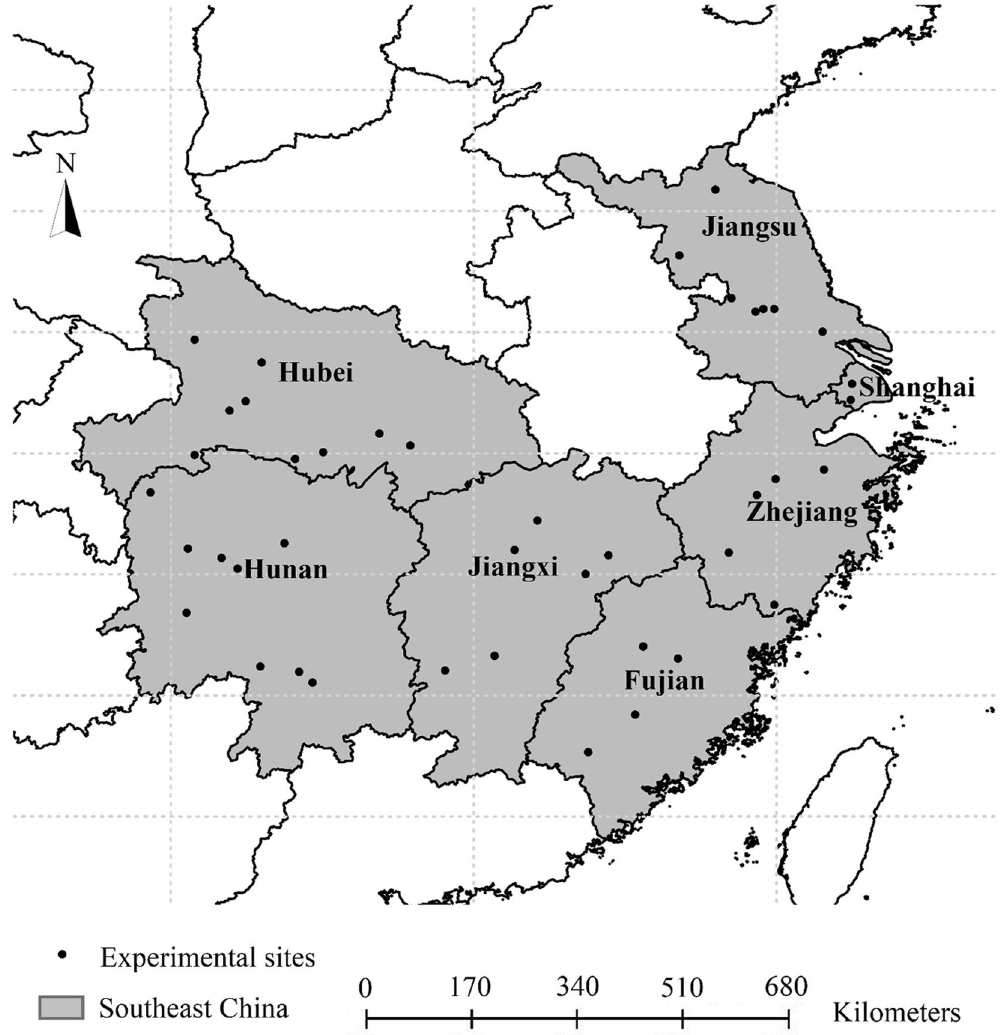
Figure 7. Locations of the experimental sites of rice projects in China that provided the datasets used in this study (plotted using ArcGIS v.10.0 software, URL: